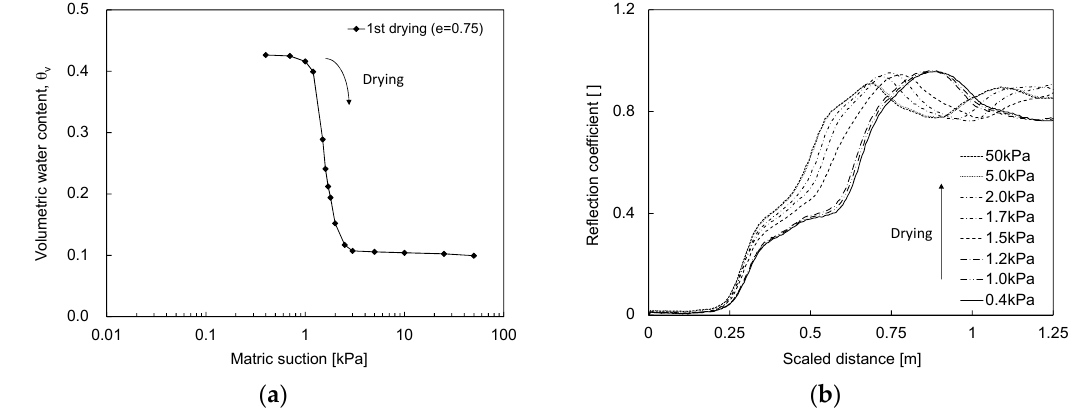
Figure 6. SWCC and TDR waveform during the drying process: ( a ) SWCC; ( b ) TDR waveform.